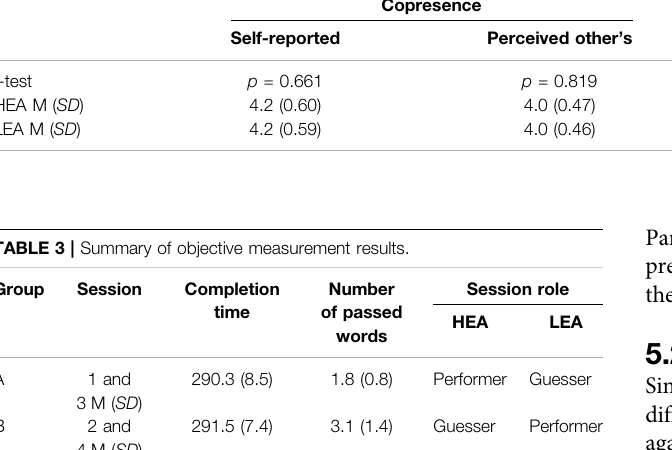
Frontiers in Virtual Reality |